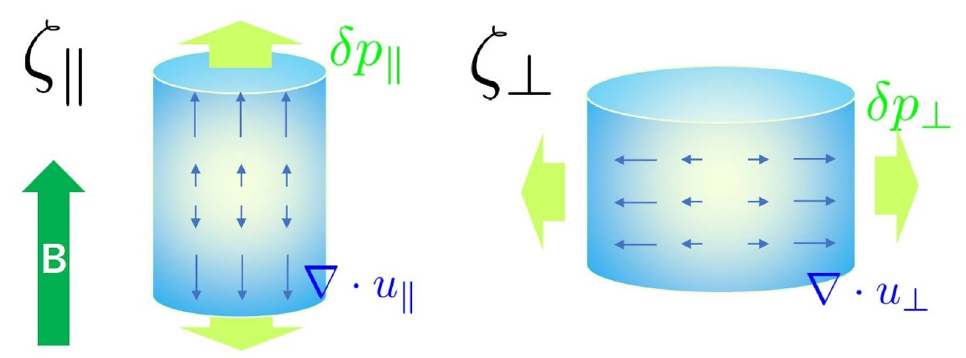
Figure 3 . Longitudinal and transverse bulk viscosities that are the off-equilibrium responses of the pressure (green arrows) in the direction of the expansion/compression (blue arrows) of the system.